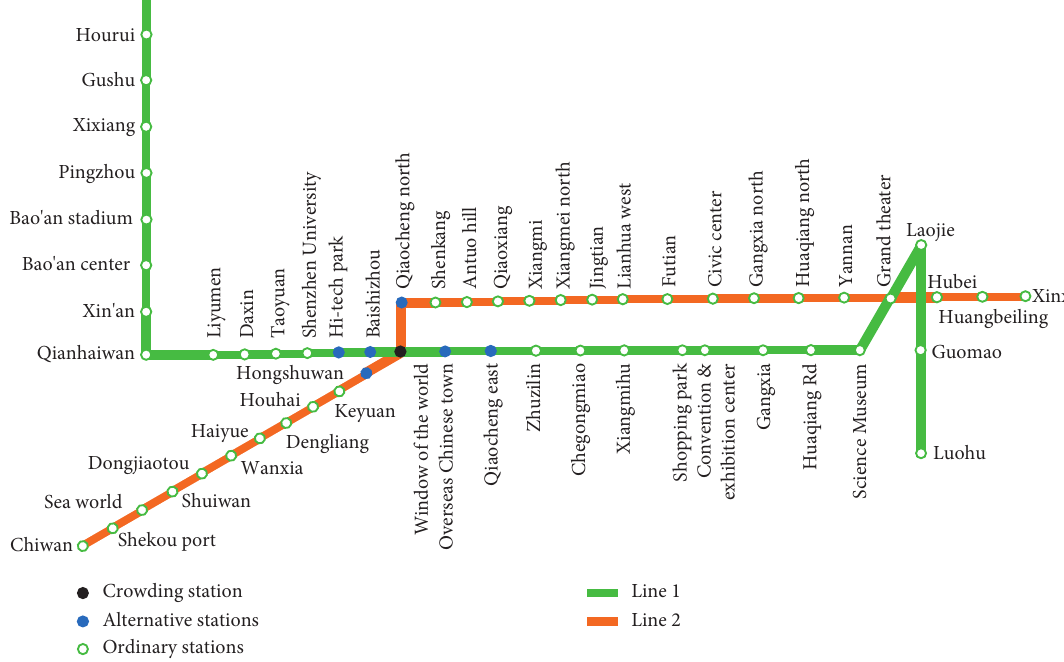
Figure 4: Line 1 and Line 2 of Shenzhen metro. The black circle represents the “Window of World” station, and the blue circles and the green circles represent the alternative stations and ordinary stations,